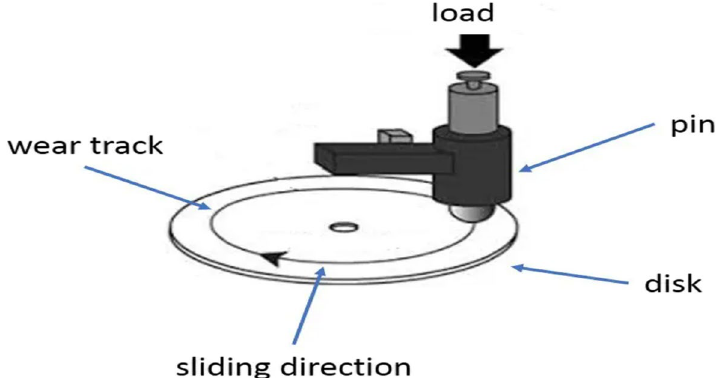
Fig. 1 Schematic representation of wear test